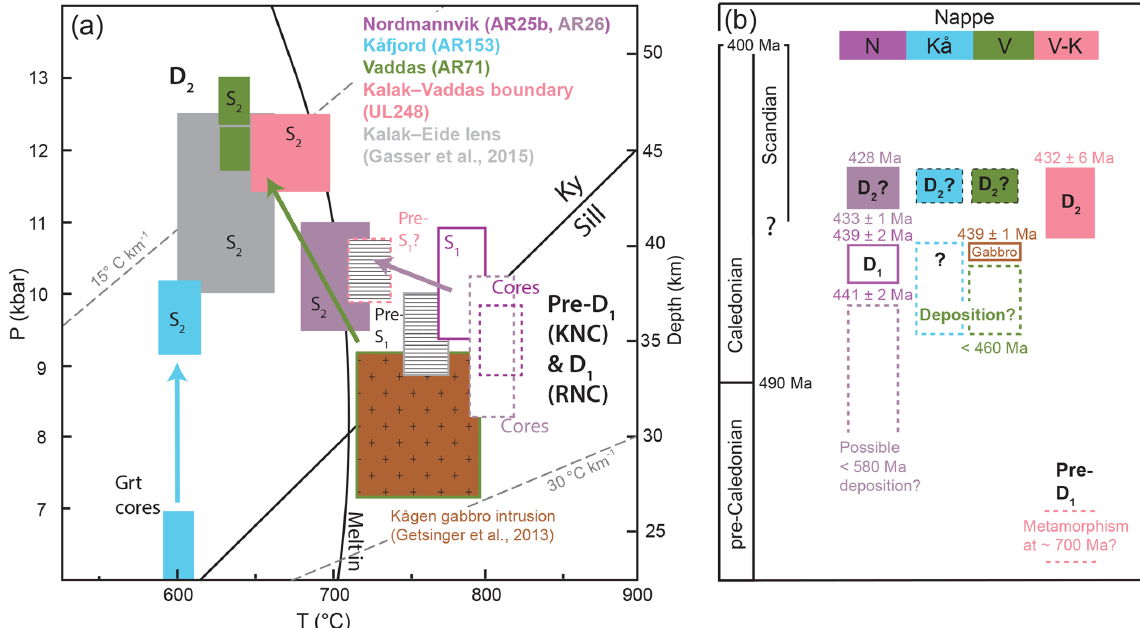
Figure 13. Summary of P – T conditions and timing for phase equilibrium modelling and geochronological results. (a) P – T diagram com- paring conditions of metamorphism for pre-S 1 foliation garnet cores (striped boxes), D 1 migmatization (solid line box), apparent garnet core conditions in the Nordmannvik Nappe (dashed boxes), and S 2 foliation formation (shearing) (filled boxes) for all nappes. Estimated conditions for metamorphism in the KNC are shown in grey (Gasser et al., 2013). The intrusion conditions for the Kågen gabbro (brown box) are from Getsinger et al. (2013). Arrows show anticlockwise P – T paths for the Nordmannvik Nappe rocks and Vaddas or lower Kåfjord metasediments. (b) Timing of magmatism and metamorphism comparing ages across the nappes of the RNC and placing them within a pre-Caledonian and Caledonian context. Titanite ages are shown as filled boxes and zircon ages as solid-line boxes. Inferred and speculative ages are shown as dashed